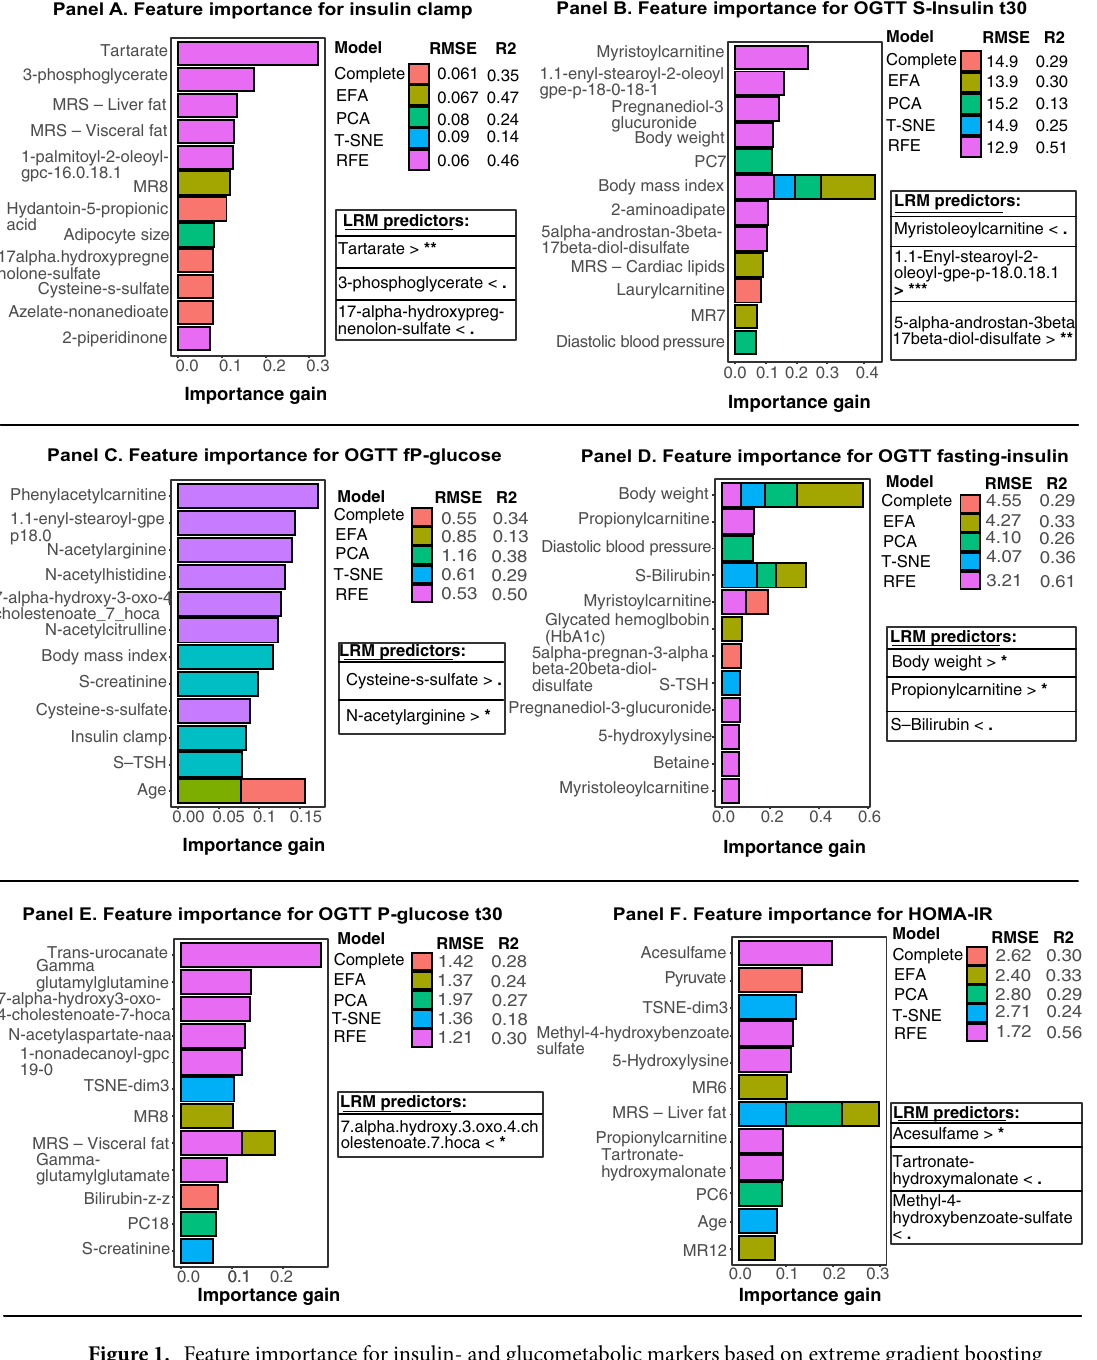
Figure 1. Feature importance for insulin- and glucometabolic markers based on extreme gradient boosting models and linear regression for the most important predictors. Panel ( A ) to Panel ( F ) displays relative importance for predictors generated by extreme gradient boosting models, using several pre-processing techniques for metabolomics data to further reduce number of predictors in the final machine-learning model. Model diagnostics ( RMSE ) and validation ( R 2 ) are presented next to each prediction model. For each outcome, the most important predictors identified through machine learning were included in linear regression models. All regression models were adjusted for age. Significance level are described as follows: * p -value < 0.05, ** p -value < 0.005, *** p -value < 0.0005. p -values < 0.095. < denotes that lower levels for the predictor was associated with the target variable. > denotes that higher levels for the predictor was associated with the target